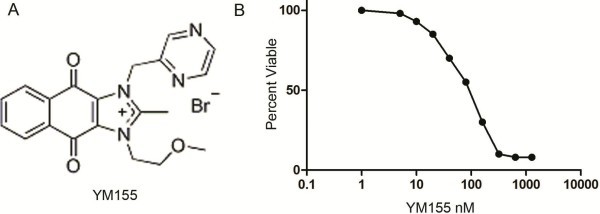
Growth inhibitory effect of YM155 on SK-NEP-1 cells. (A) Molecular Structure of YM155. (B) Proliferation and IC50 analysis of YM155. Sk-NEP-1 cells (2 × 104) were seeded in 96-well plates overnight and incubated with DMSO, 1 nM YM155, or increasing concentrations of YM155 (0.005, 0.01, 0.02, 0.04, 0.08, 0.16, 0.32, 0.64or 1.28 μM) for 24 hours. Compared with the control group, the relative survival rate of remained cells was calculated from the absorbance values. Cell proliferation was calculated as a percentage of the DMSO treated control wells with IC50 values derived after plotting proliferation values on a logarithmic curve. Experiments were performed in quadruplicate and repeated two times.